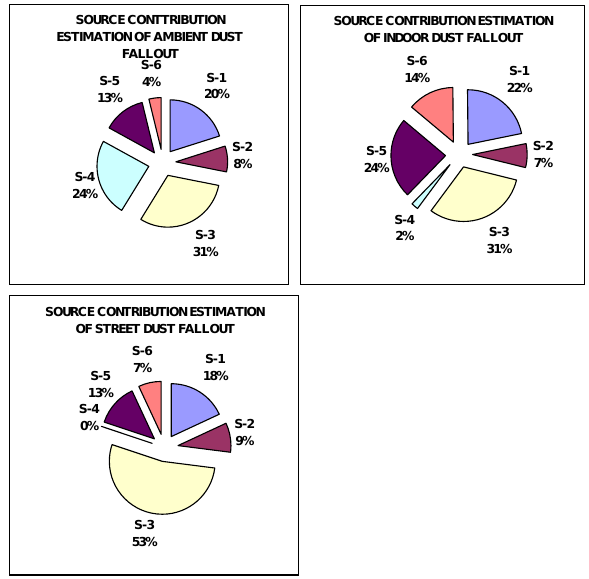
Fig 3: Relative source contribution estimation of dust fallout at selected classified atmospheric levels at receptor.